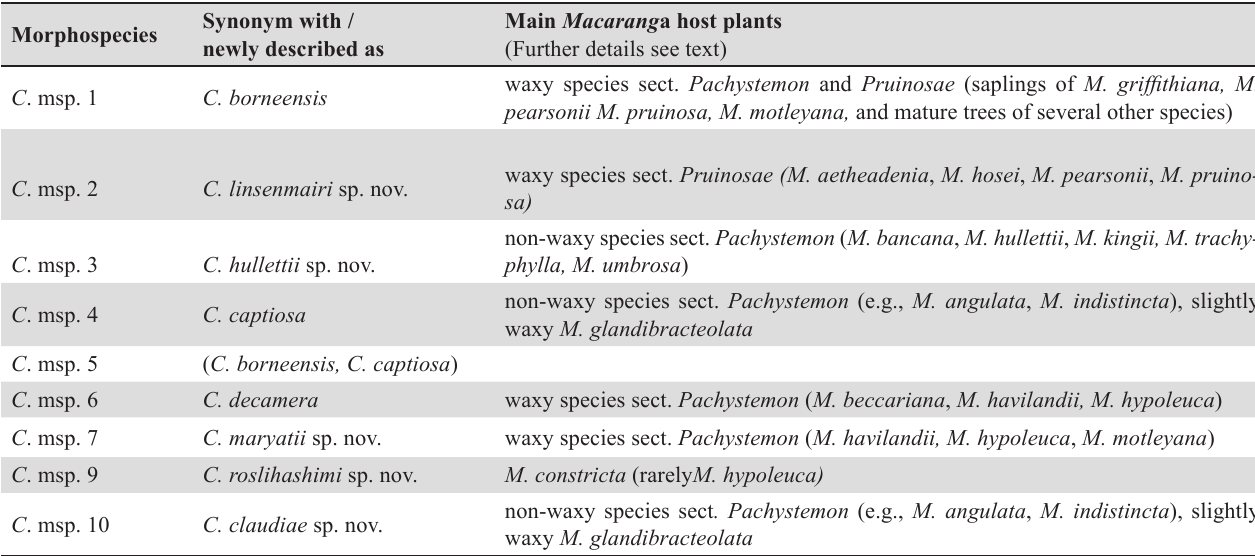
Table S.1 : Overview of morphospecies numbers formerly used for Macaranga -associated Crematogaster ( borneensis -group) ants in publi- cations of Feldhaar, Federle, Fiala, Heil, Maschwitz and coworkers vs. synonymised or newly described